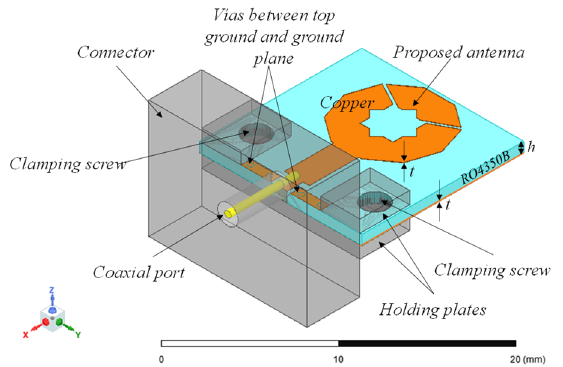
Figure 2. Antenna structure defined in the full-wave simulator, including the connector (h = 0.787 mm, t = 17.5 µm).